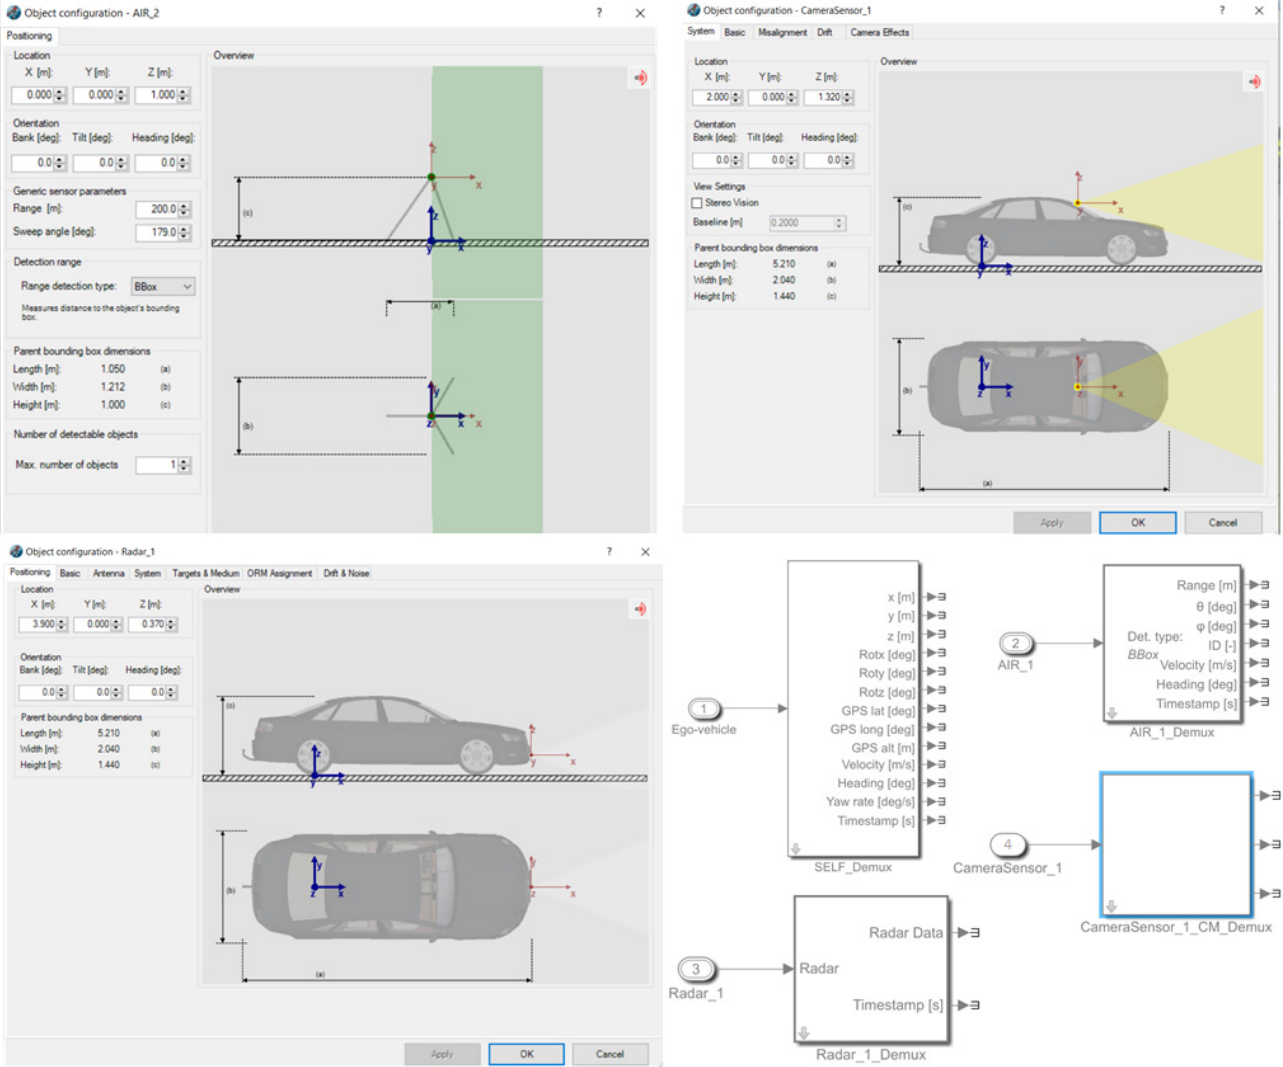
Figure 8. Sensor’s parameters in PreScan GUI converted to module blocks in Simulink interface (bottom right).